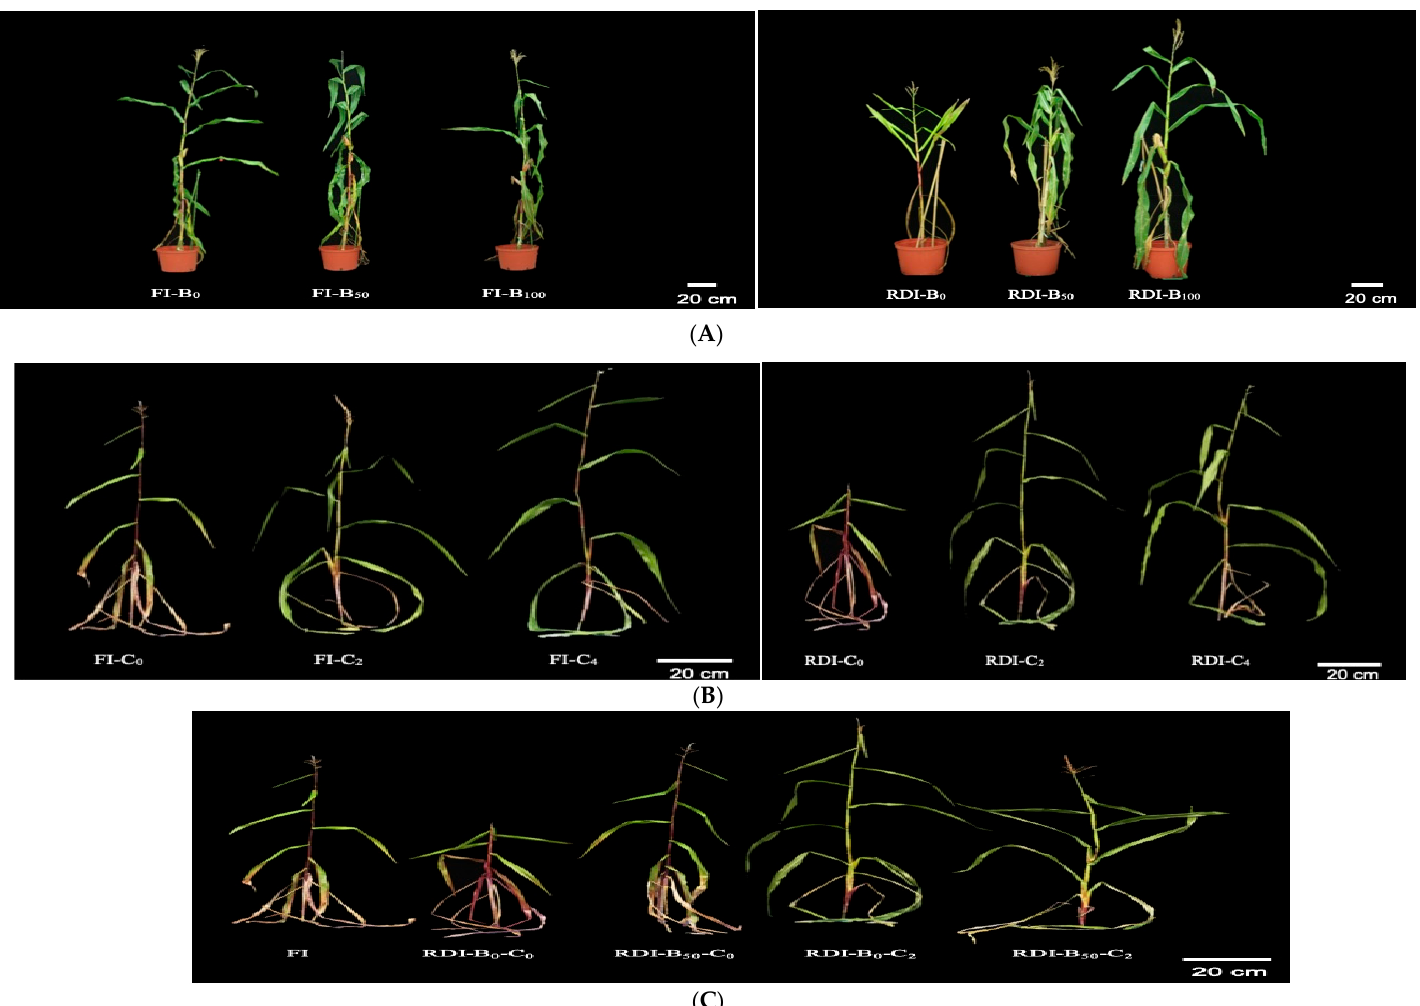
Figure 1. Effects of different concentrations of betaine ( A ), chitin ( B ), and betaine and chitin ( C ) on the morphological appearance of maize ‘White Pearl’ plants under full irrigation (FI) and regulated deficit irrigation (RDI). Betaine (0, 50, and 100 mM/plant) was foliage-treated, but chitin (0, 2, and 4 g/kg) was applied to the soil. Bar indicates 20 cm.